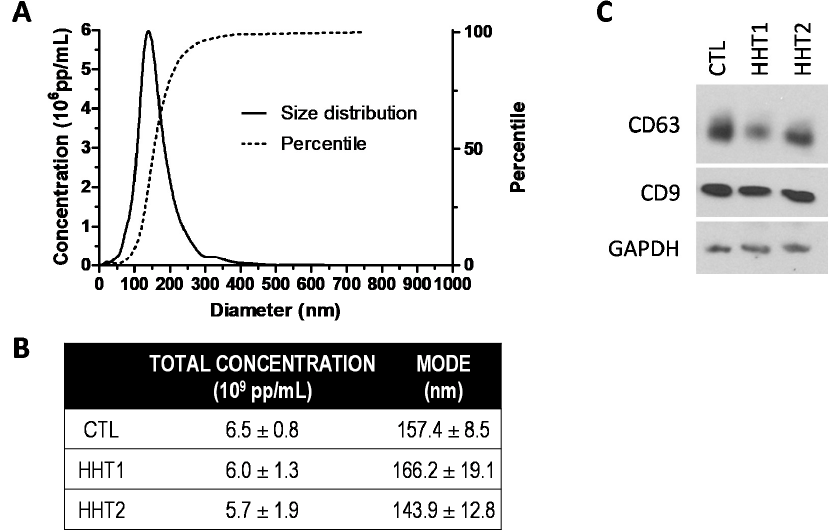
Figure 1. Plasma exosome characterization. ( A ) A representative graph from NTA analysis for size distribution and concentration determination of plasma exosomes is shown. ( B ) The total concentration and diameter mode of exosomes were calculated for CTL, HHT1, and HHT2 groups (mean ± standard deviation). ( C ) Classical exosome markers were detected by Western blot.